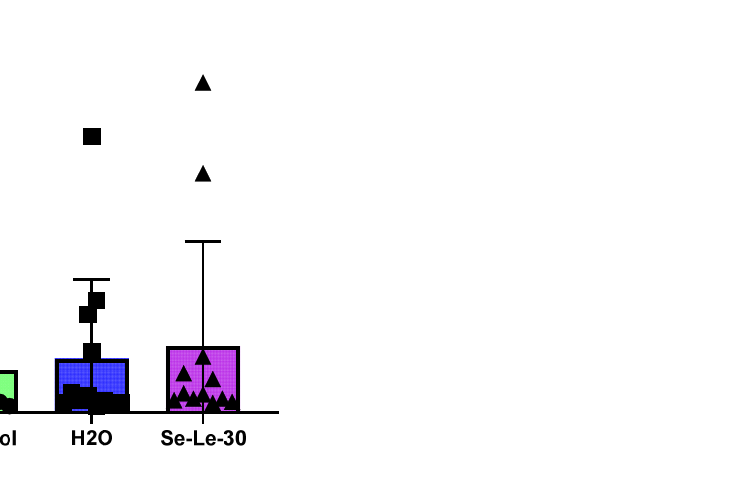
Figure 5. Effect of Se-Le-30 on CD3 + T cell viability. Evaluation of CD3+ T-cell viability after 24h culture with Se-Le-30 (100 µ g/mL), with an equivalent amount of water for injection (H2O) or culture medium (control), was performed using Zombie Violet™ staining by flow cytometry. Cells were considered dead when they showed high violet fluorescence at 450 nm. Repeated measures one-way ANOVA test, p = 0.2076. Points on bar charts represent experiments conducted with individual donors.